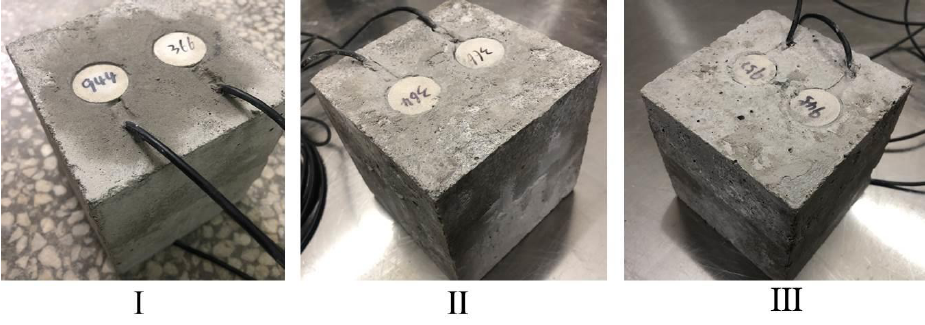
Figure 7. Composite specimens after installation of SAs.